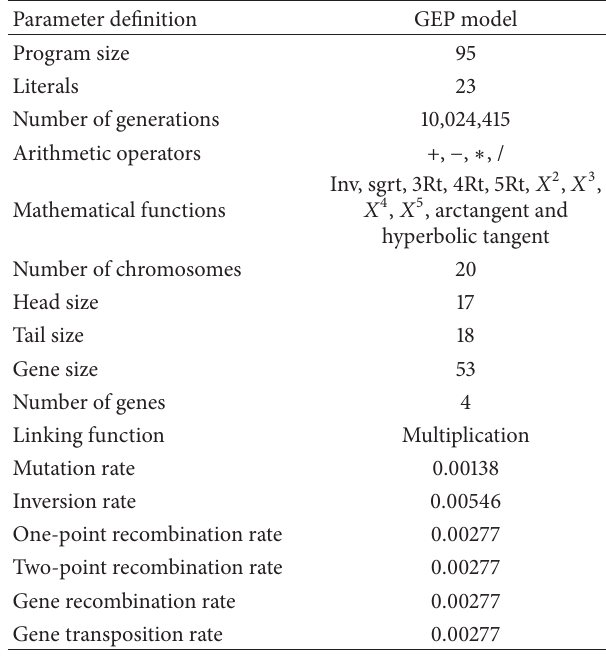
Figure 5: Comparison of static and dynamic elasticity. Table 4: GEP parameters used for the developed model.